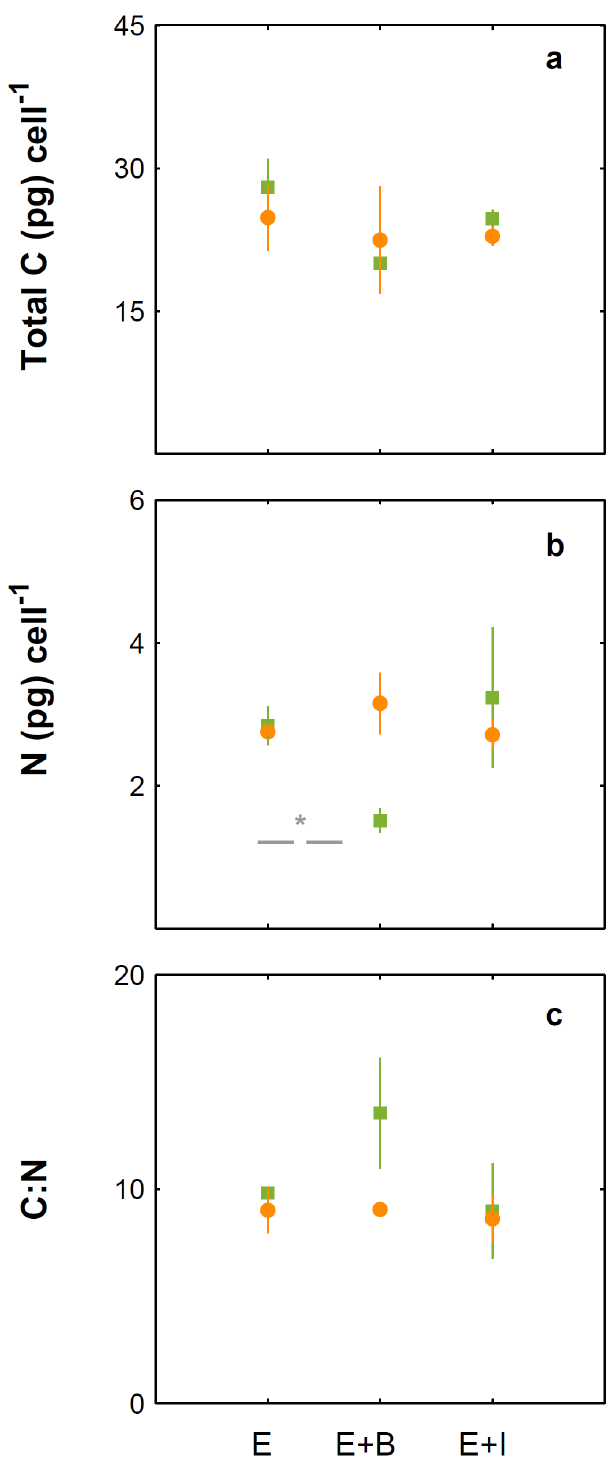
Figure 4. Cellular element quotas of E. huxleyi monocultures and E. huxleyi co-cultured with Brachybacterium sp. (E + B) and I. abyssalis (E + I), under 475 (green) and 1056 µatm (orange). Total particulate carbon ( a ), nitrogen ( b ) and carbon to nitrogen ratio ( c ). * Denotes significant differ- ences.